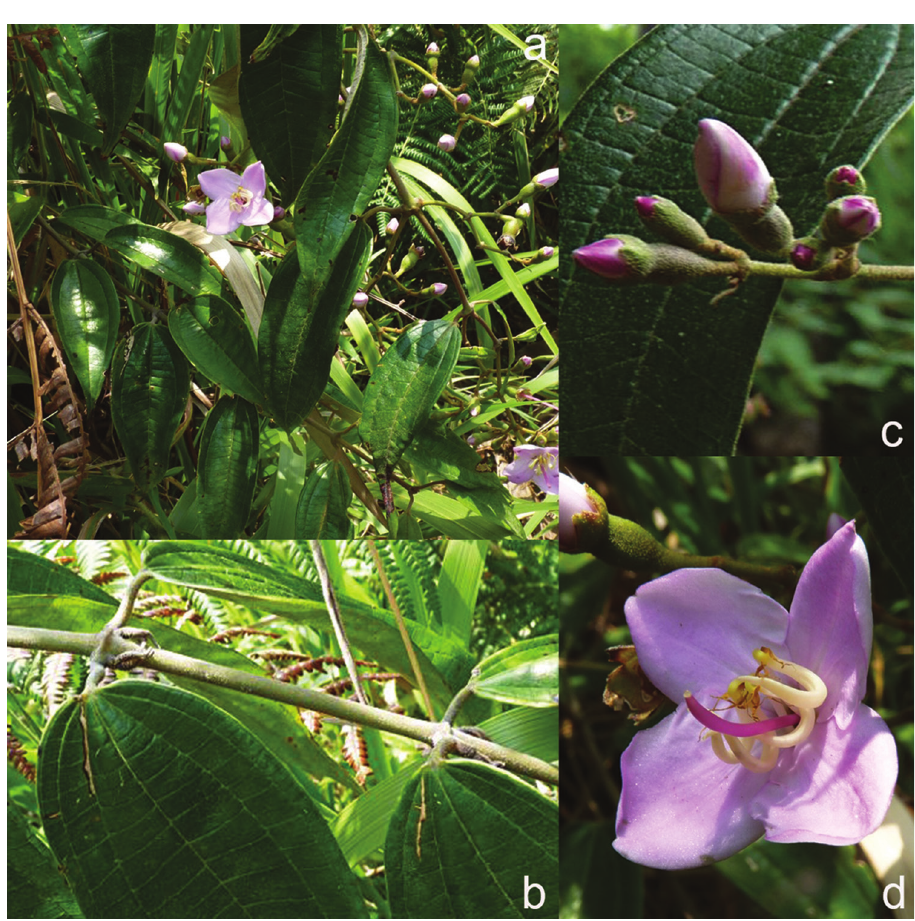
Figure 20. Dissochaeta leprosa a habit b branchlet c hypanthium d flower. Photographs by C. Bravard. variety of D. intermedia , but because of the differences in size and shape of the hyp- anthium, the calyx lobe tips and the alternipetalous stamens, it is considered to be a distinct species (Kartonegoro and Veldkamp